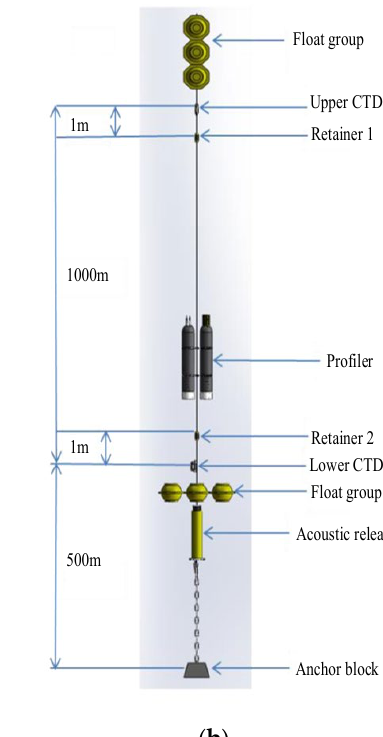
Figure 1. The self-designed ARTP. ( a ) The main structure of the ARTP; ( b ) The whole observation platform.